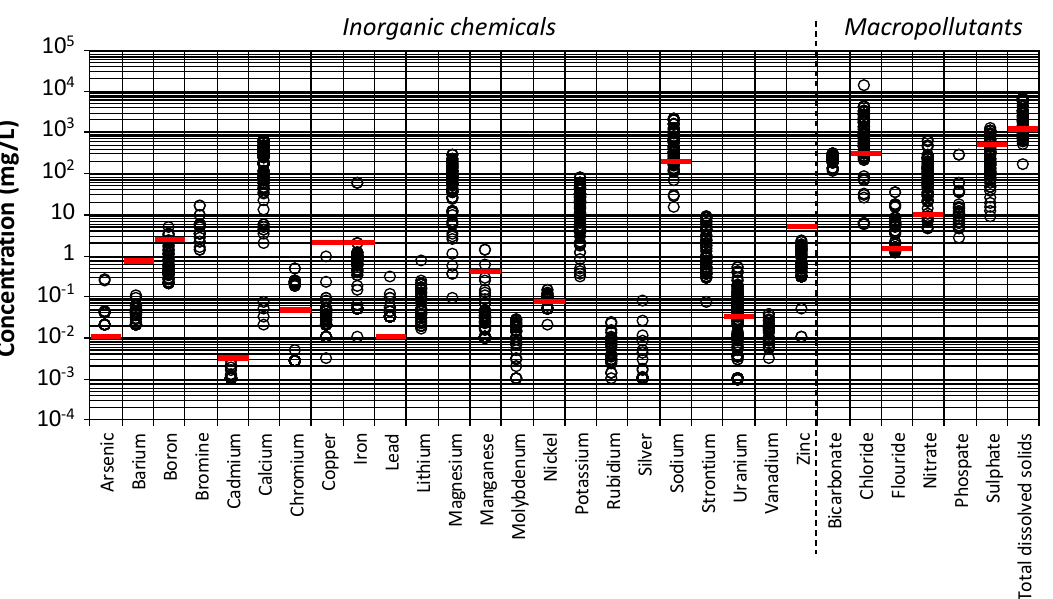
Figure 6. Observed concentrations (circles) inorganic chemical and macropollutants in groundwater in the reviewed studies referring to South Africa and the corresponding limits (red dashes) set by SANS-241 (red line) for drinking water. Data from: [5,21–23,35,52,53,57].